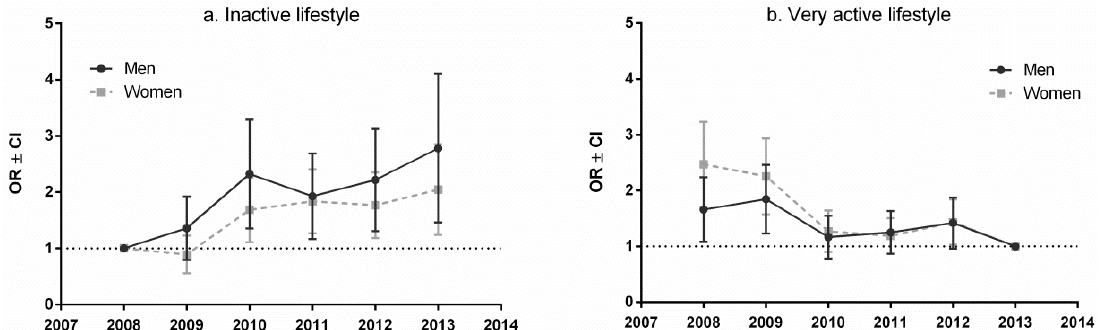
Figure 1. Odds ratios (OR) and confidence interval (CI) for inactive ( a ) and very active ( b ) lifestyle in survey periods 2008–2013.